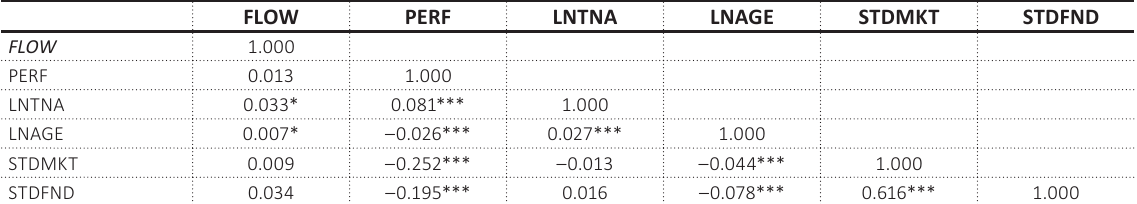
Table 2. Correlation matrix